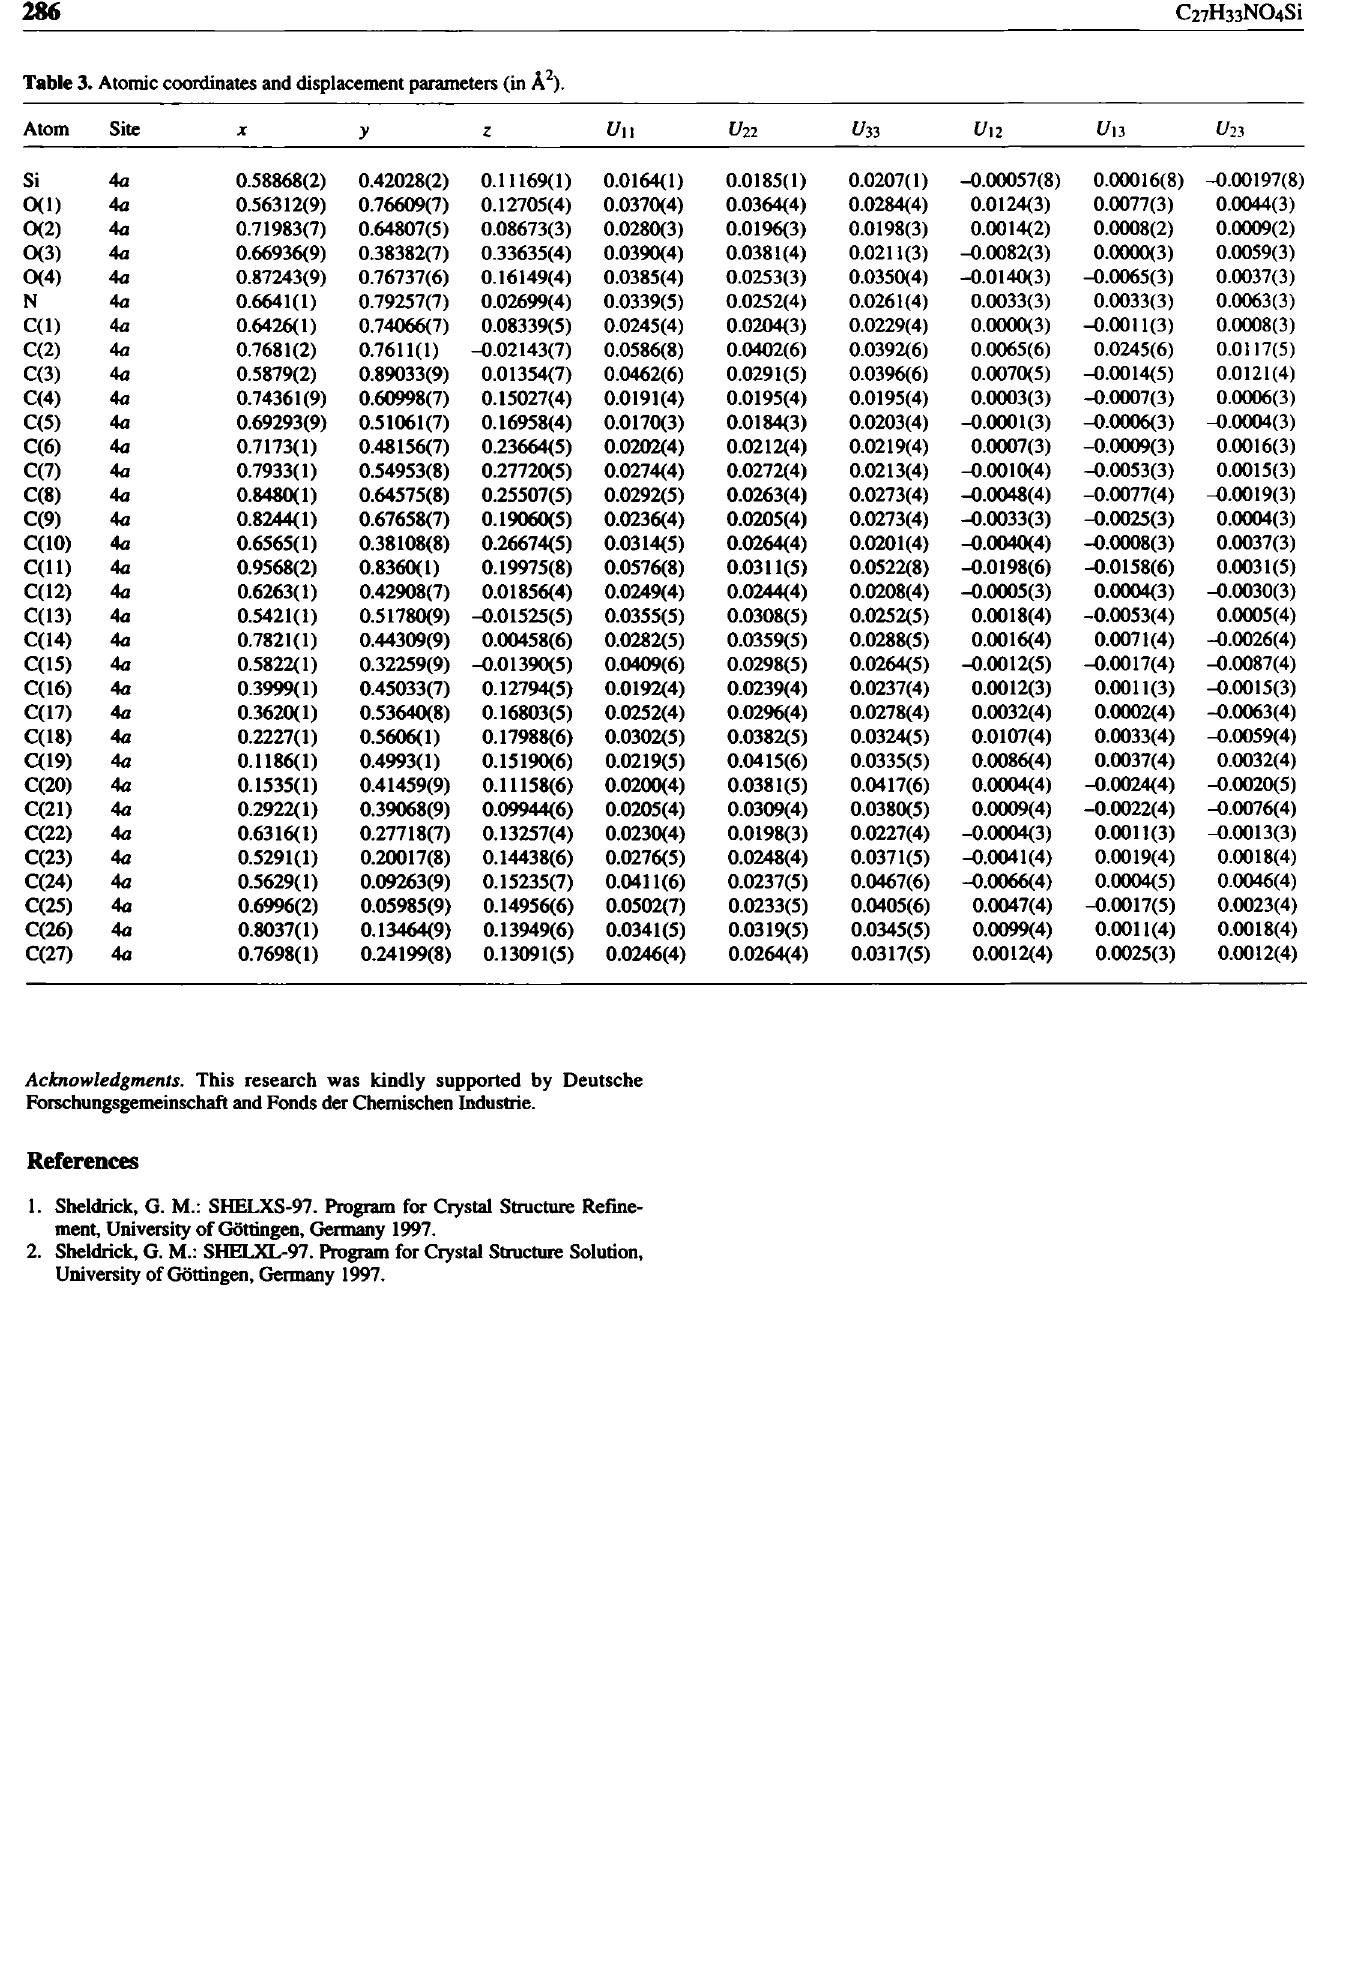
Table 3. Atomic coordinates and displacement parameters (in Â 2